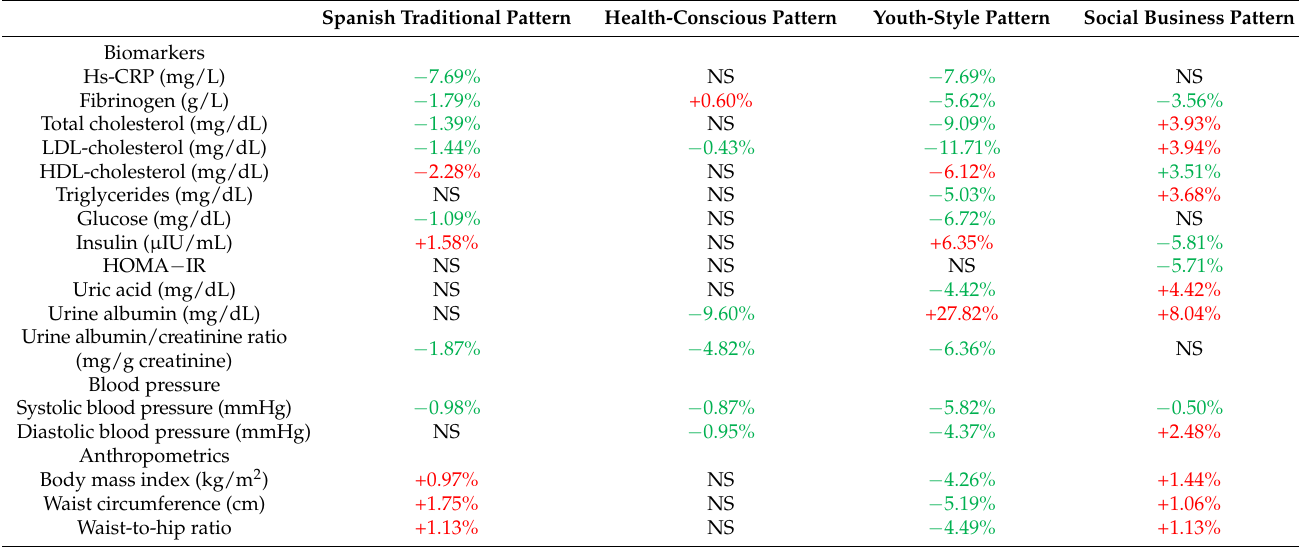
Table A2. Relative changes in the adjusted estimators of extreme quartiles of inflammatory and cardio-metabolic biomarkers, blood pressure, and anthropometrics, according to the cooking and food preservation